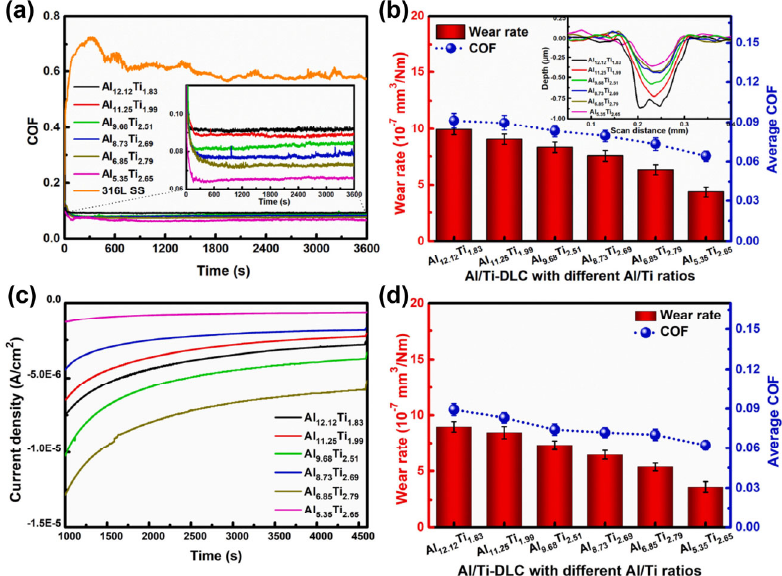
Fig. 13 (a) Friction curves and (b) average wear rate and COF values of films in 3.5 wt% NaCl solution, in which the insets are enlarged friction curves and depth profiles of the wear tracks, respectively. (c) Current evolution curves and (d) average wear rate and COF values of films under cathodic protection conditions [176]. Reproduced with permission from Ref. [176], © Elsevier B.V.,